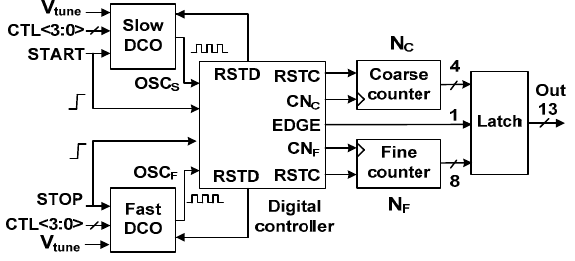
Figure 2. Block diagram of the proposed TDC. CN C and CN F : coarse and fine counter clock signals; DCOs: digitally-controlled oscillators.